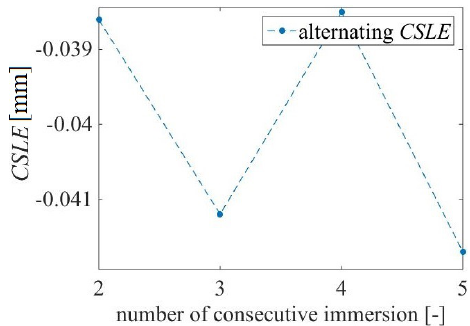
Figure 8. Measured period doubling characteristics; Parameters: w = 4 [mm], h 0 = 0.2